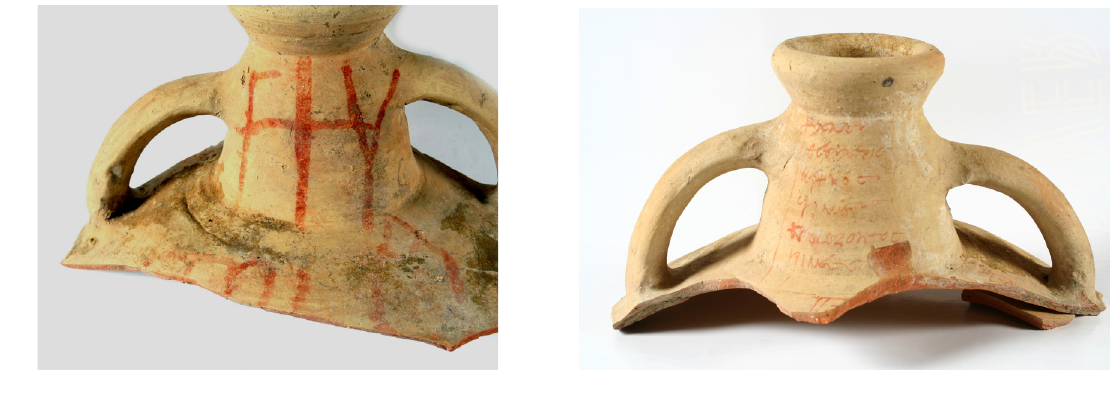
Figure 4. Side I: dipinti with large letters. Figure 5. Dipinti on side